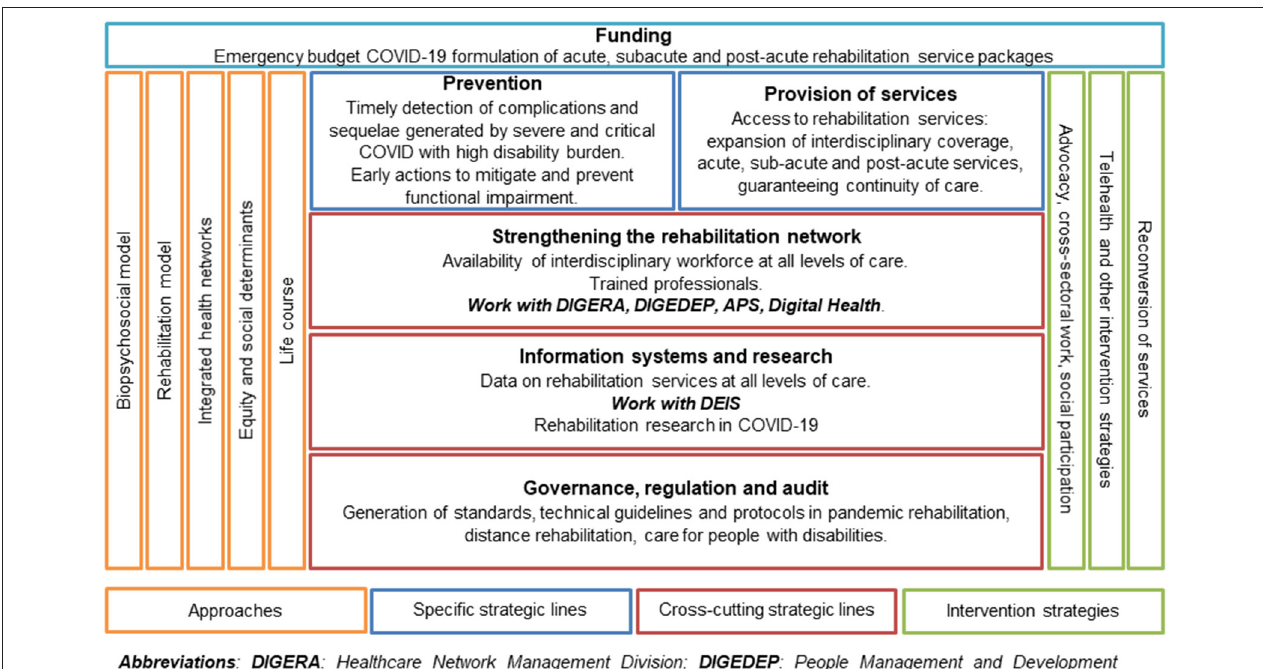
FIGURE 1 | Matrix of access to rehabilitation services during the COVID-19